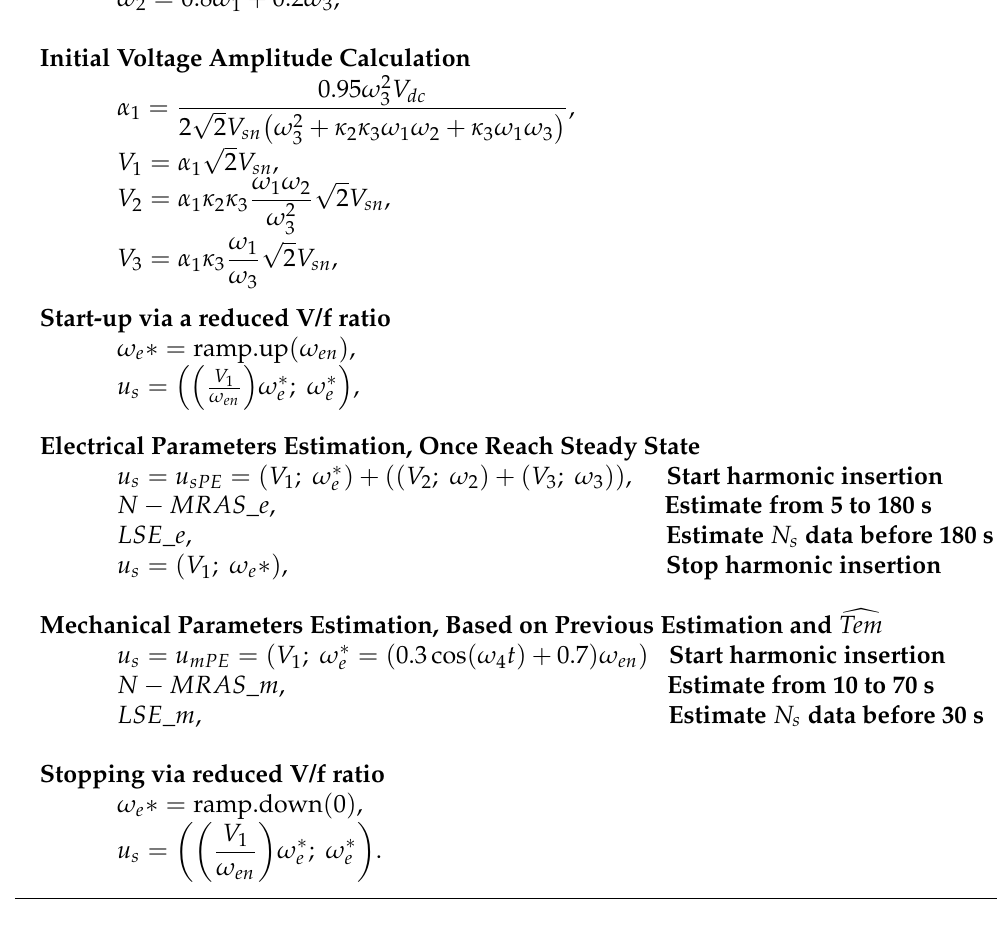
Algorithm 1 Pseudocode of the Proposed Initial Tuning Parameter